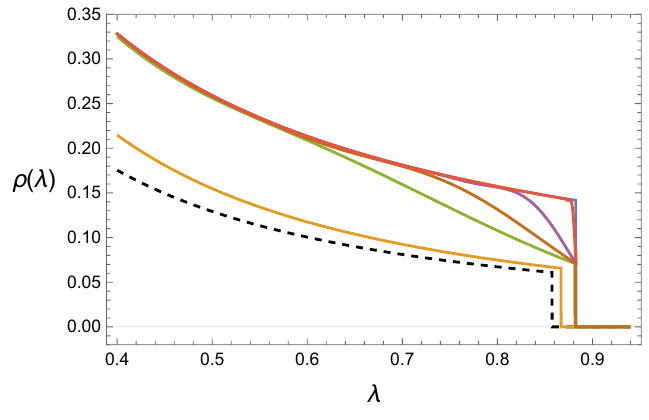
√ 3 . The dashed line is for the SAdS black hole, 4 √ 3 , respectively. Here we plot only the